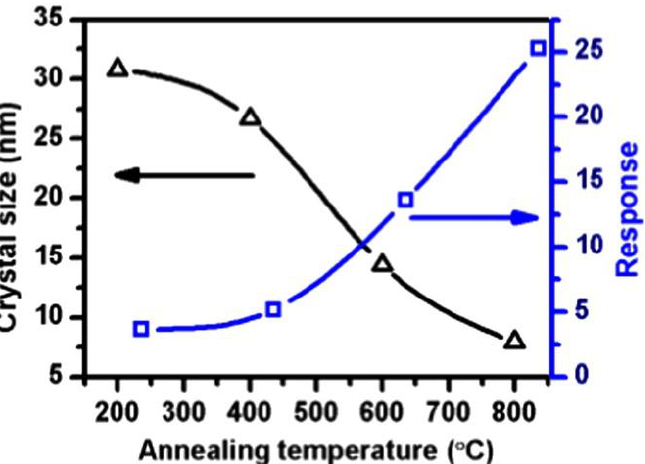
Figure 6. Sensing response and crystalline size of the SnO 2 samples as a function of the annealing temperature [53]. Black line with triangle symbols shows variations of crystal size with annealing temperature and blue line with square symbols shows variations of response with annealing tem- perature.